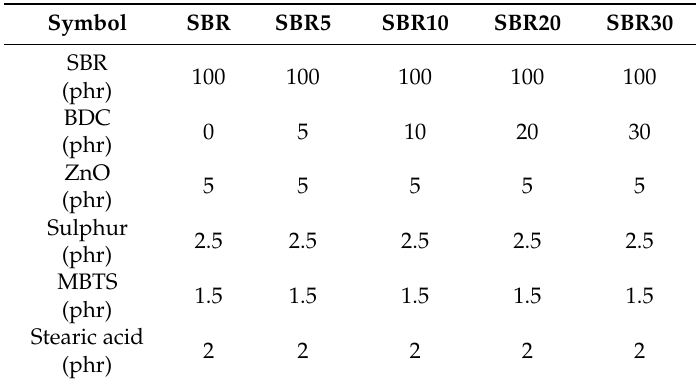
Table 1. Composition of the Styrene–Butadiene Rubber (SBR) composites. Symbol SBR